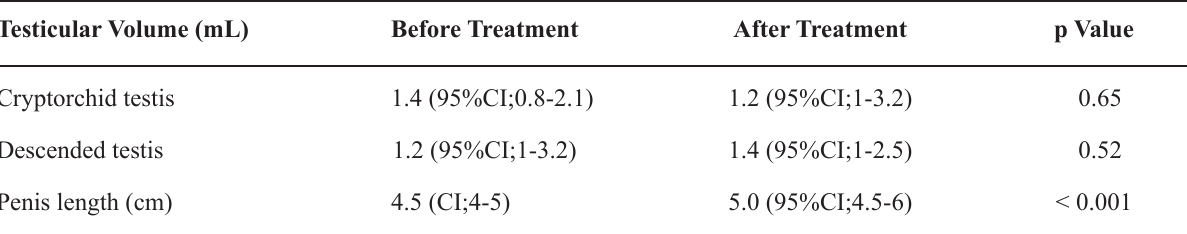
Table 4 – Characteristics of genitalia in boys treated with LH-RHa before and after treatment. Testicular Volume (mL) Before